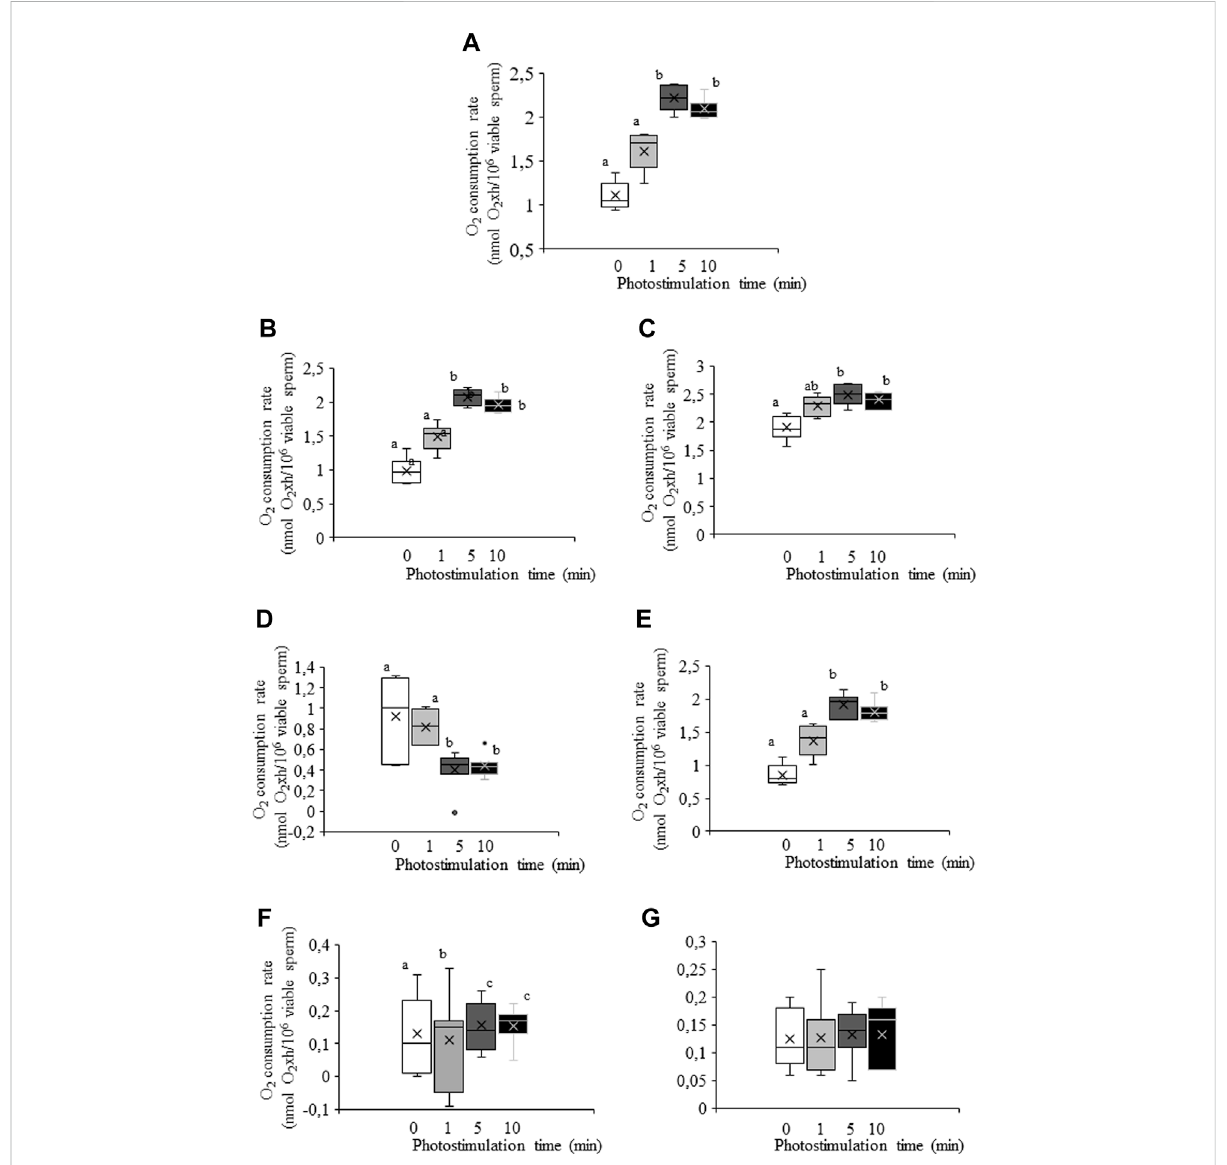
FIGURE 5 Box-and-whiskerplotoftheeffectsofredLEDlightirradiationonO 2 consumptionrate.SpermweresubjecttoseparateredLEDlightirradiation patternsbeforetotalO 2 consumptionratewasanalyzedanddividedintoitscomponentsasdescribedinMaterialsandMethodssection.Spermwere not irradiated (white boxes) or irradiated with red LED light for 1 min (light grey boxes), 5 min (dark grey boxes) or 10 min (black boxes). (A) total consumption rate, de fi ned as the sum of non-mitochondrial O 2 consumption, basal respiratory rate and spare respiratory capacity. (B) basal respiration. (C) maximal respiration. (D) spare respiratory capacity. (E) ATP turnover. (F) H + leak. (G) non-mitochondrial O 2 consumption. Figure shows means ± S.E.M. for 8 separate experiments. Figure shows means ± S.E.M. for eight biological replicates involving eight independent samples. Asterisks inside boxes indicate means, whereas lines inside represent medians. Different superscript letters indicate signi fi cant ( p < 0.05) differences between irradiation patterns (i.e., 0, 1, 5 or 10 min). Superscripts were not needed in Figure 5G, as no signi fi cant differences were